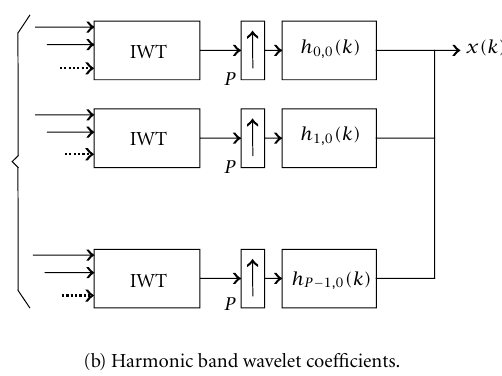
Figure 9: Harmonic-band wavelet transform: (a) analysis and (b) synthesis structures.